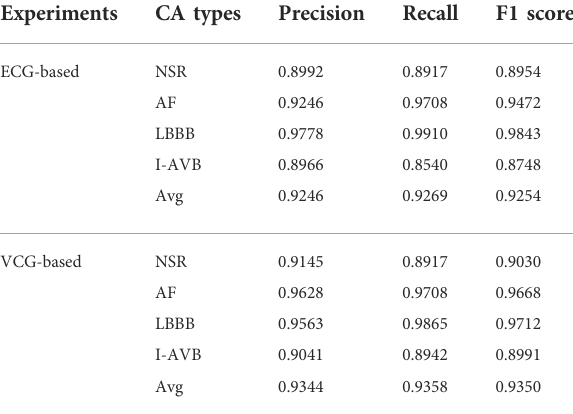
TABLE 3 Classi fi cation Precision/Recall/F1-score of